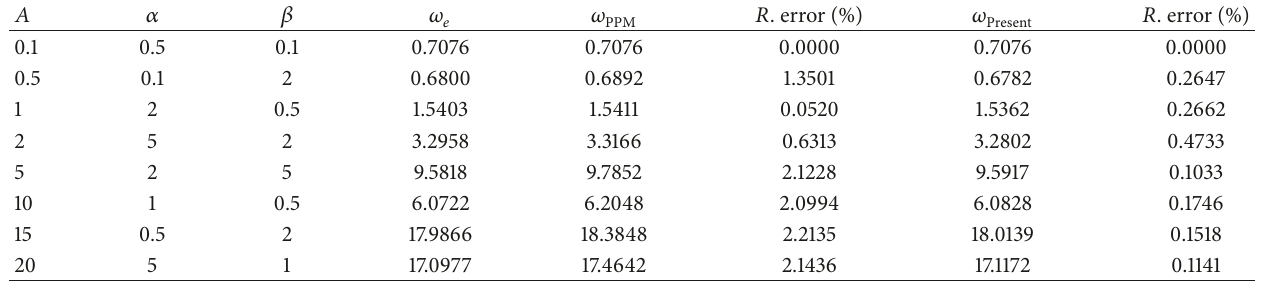
Table 1: Comparison of the approximate frequencies with the exact frequency, Example 1.